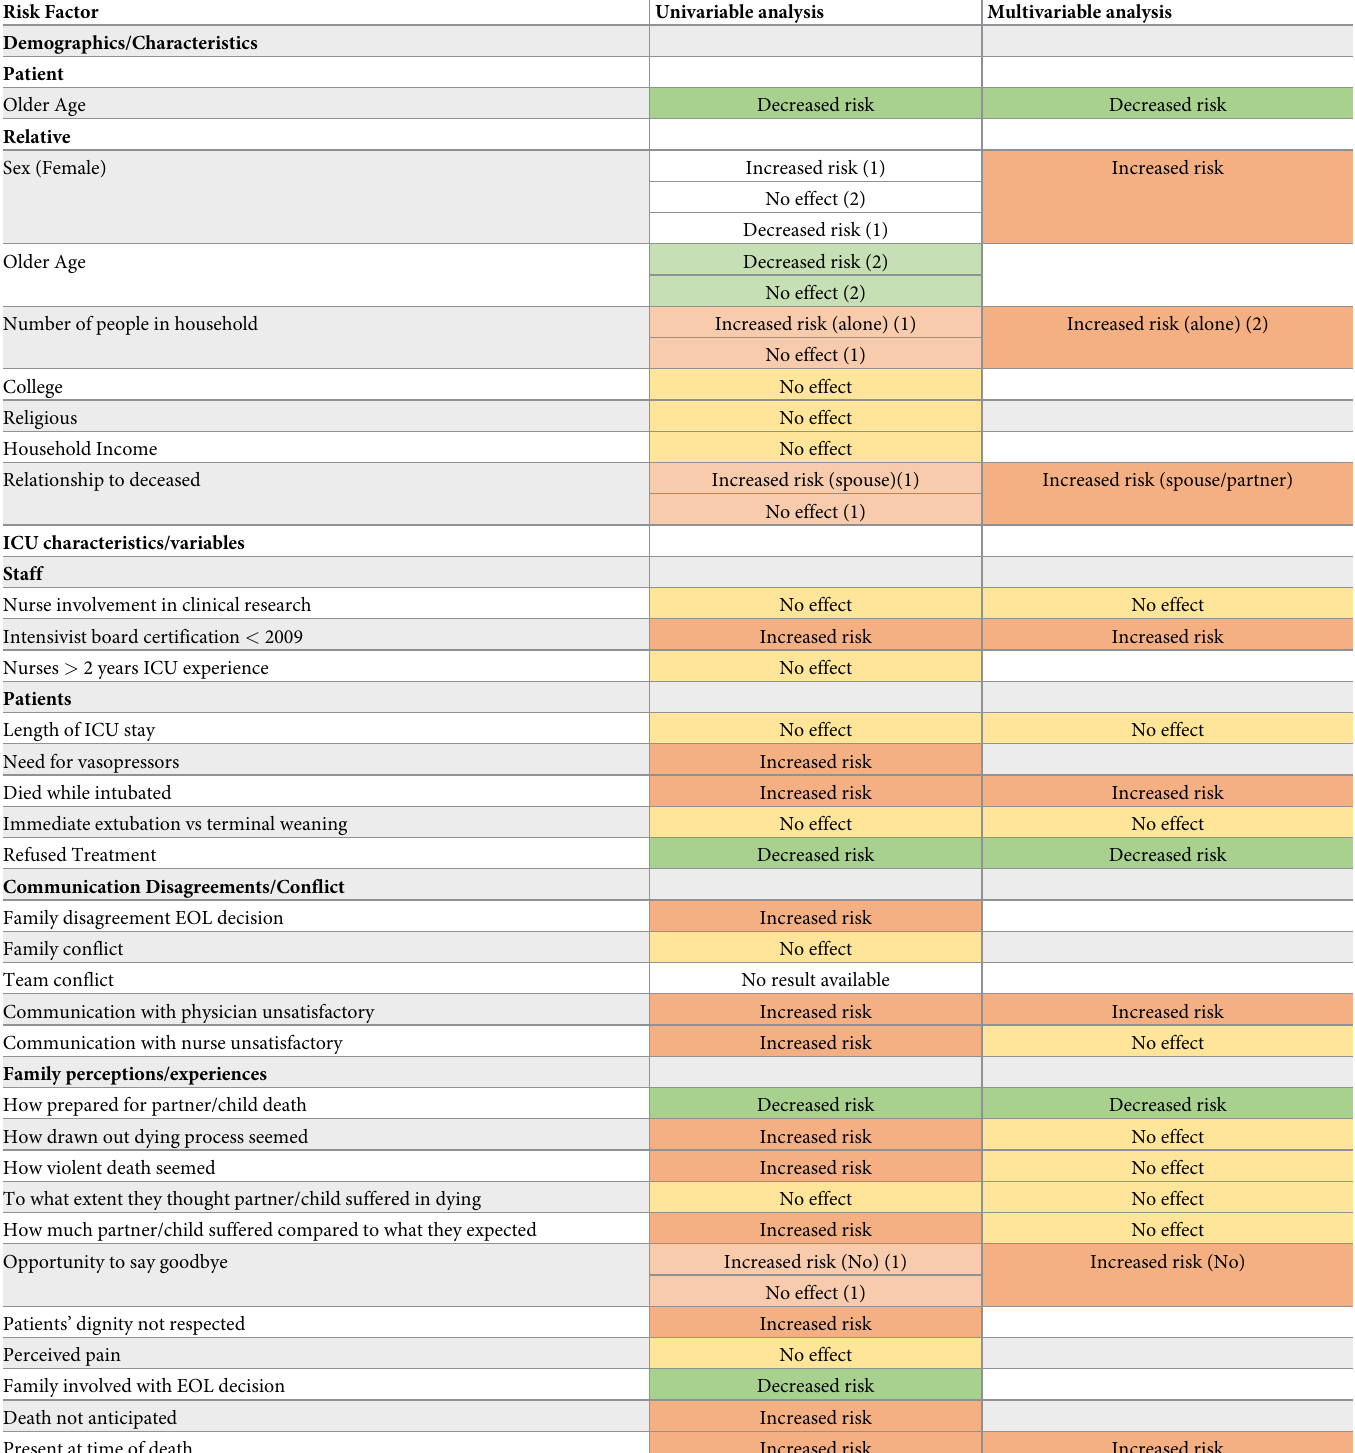
Table 5. Table indicating whether a risk factor showed a significant association with complicated grief for any time point in the study. Association shown for uni- variable analysis, multivariable analysis and for other associations, if